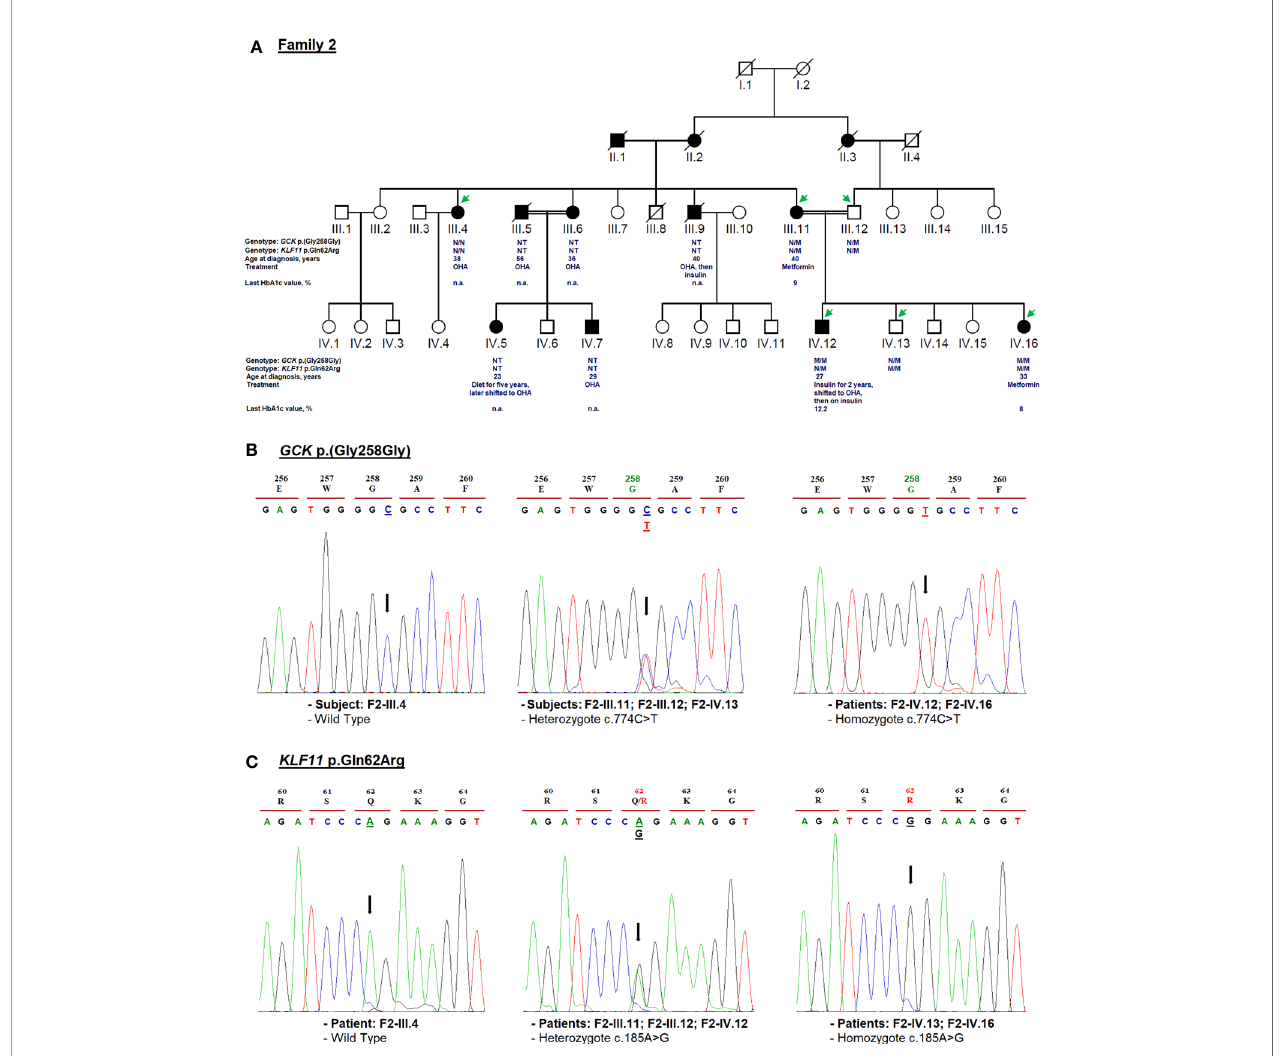
FIGURE 3 | Mutation analysis of the GCK and KLF11 genes. Panel (A) Pedigree of the family F2 identi fi ed with GCK [NM_000162.5: c.774C>T, p.(Gly258Gly)] and KLF11 variants (NM_003597.5: c.185A>G, p.Gln62Arg). OHA, oral hypoglycemic agents; NT, not tested; n.a, Not available. M and N denote mutant and wild-type alleles, respectively. Clinical information such as the age of diabetes onset, treatment follow-up, and last HbA1c measurement is indicated directly below the genotype for p.(Gly258Gly) and p.Gln62Arg variants. Panel (B) Electropherogram analysis of GCK gene in the family F2. Panel (C) Validation of the KLF11 c.185A>G variant segregation by Sanger sequencing. Mutated nucleotides on the chromatographs are depicted with an arrow. Amino acid substitution is indicated in